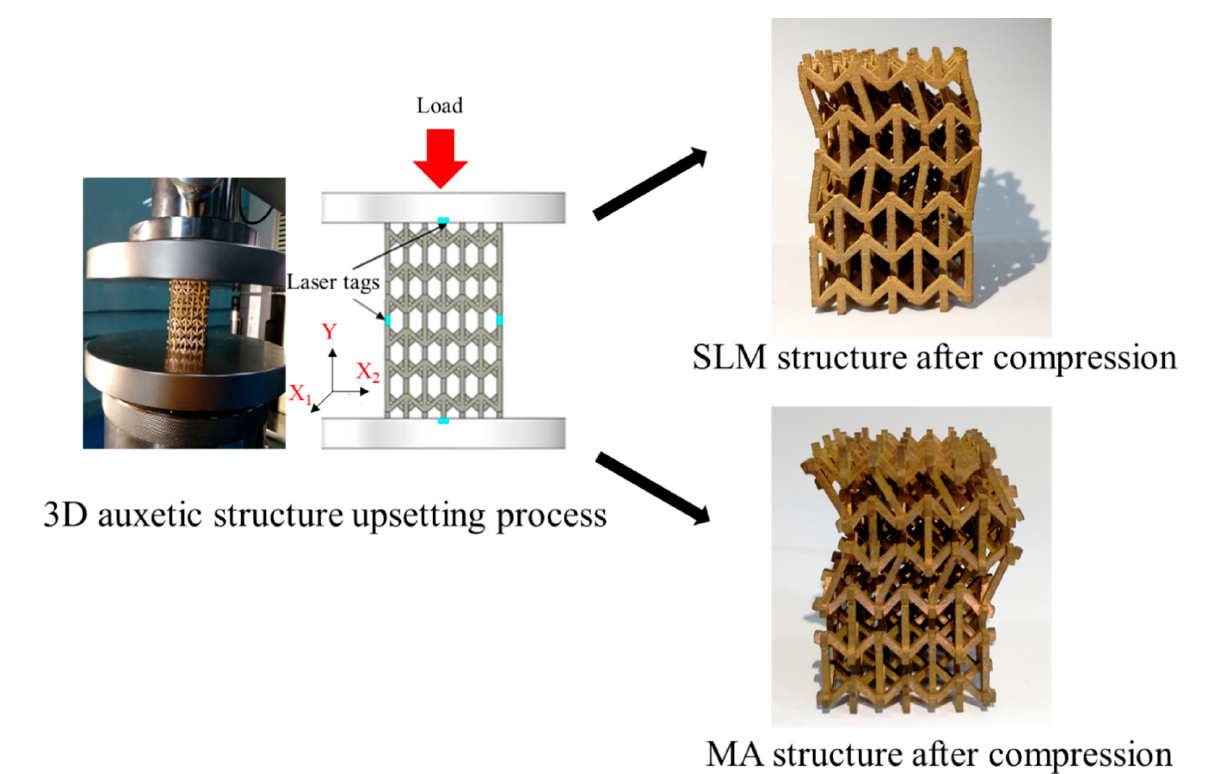
Figure 3. Quasi-static compression test for SLM and MA 3D auxetic structure.